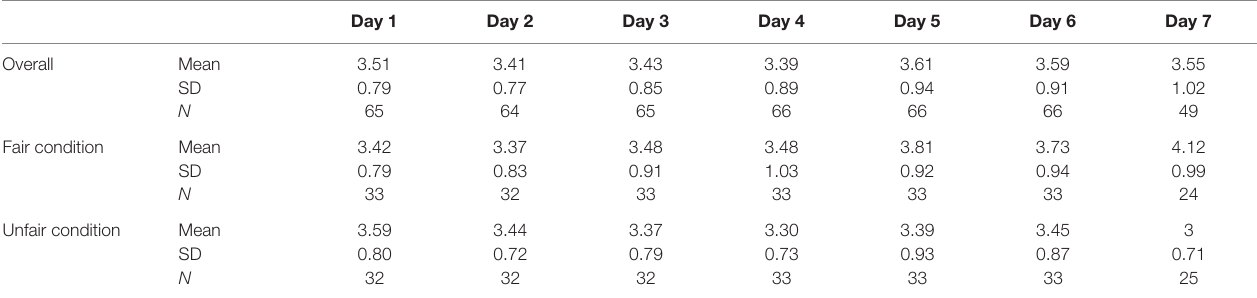
TaBle 2 | Means and sDs of energy use for each day of the week for the whole sample, fair and unfair condition.